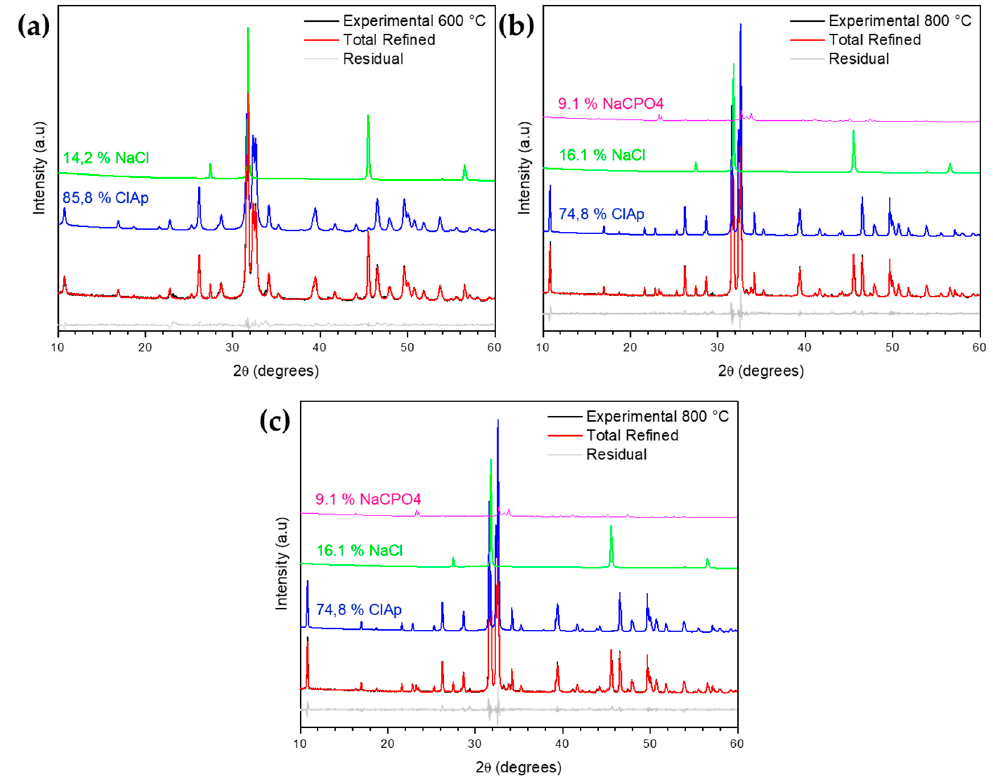
Figure 4. Experimental XRD pattern of the chlorapatite by the Rietveld method: ( a ) ClAp600; ( b ) ClAp800; and ( c ) ClAp1000. Table 1. Volume fraction of phases and crystallite size of ClAp powder derived from fish scales at different calcination temperatures.